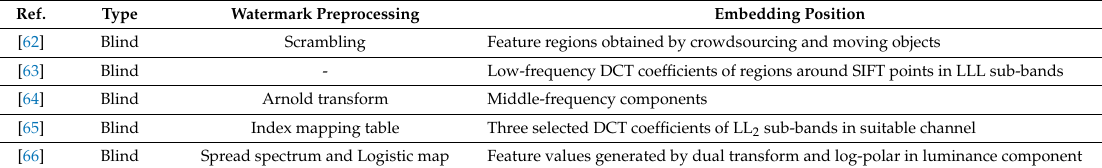
Table 6. Summary comparison of several watermarking algorithms in hybrid